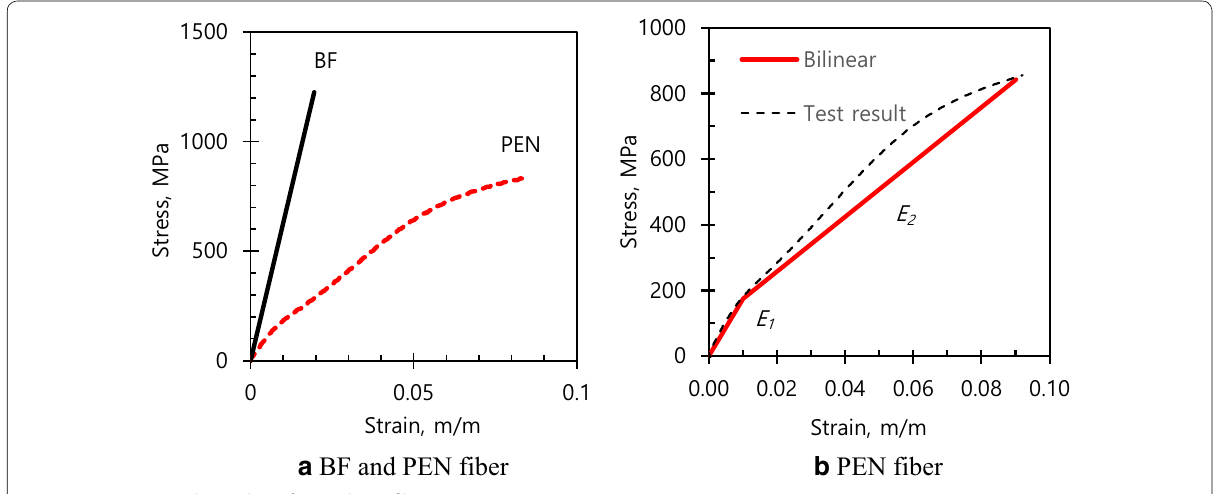
Fig. 3 Stress-strain relationship of BF and PEN fiber.